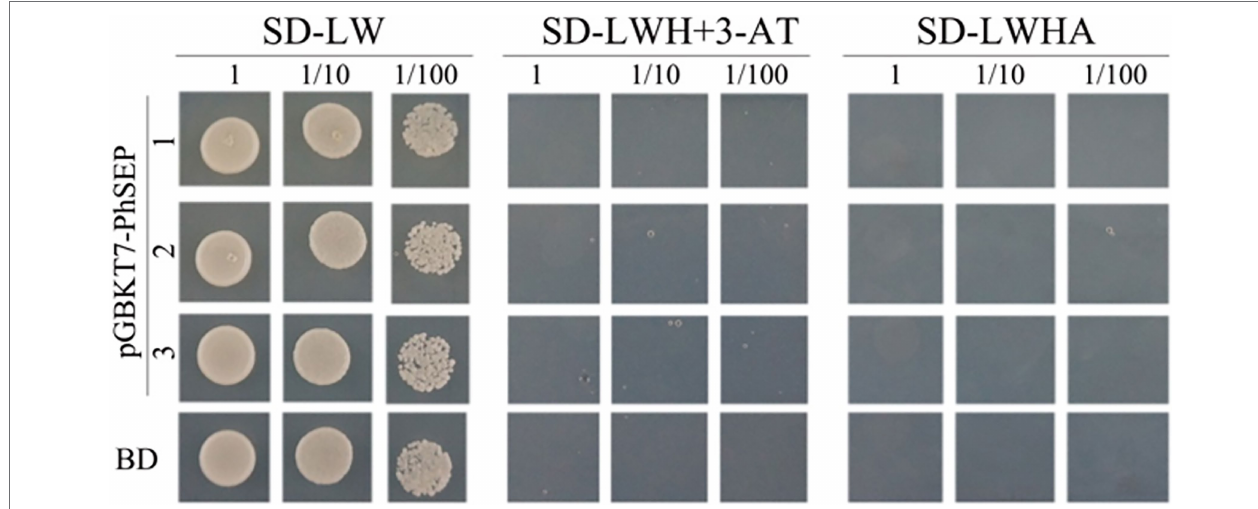
FIGURE 6 | Evaluation of the self-activation ability of PhSEPs in budding yeast. The yeast cells of strain AH109 harboring the indicated plasmids were grown on non-selective (SD-LW) or selective (SD-LWH + 3-AT and SD-LWHA) media. Decreasing cell densities represent the 10-fold dilution series. BD in the last row represents an empty GAL4 DNA-binding domain containing a